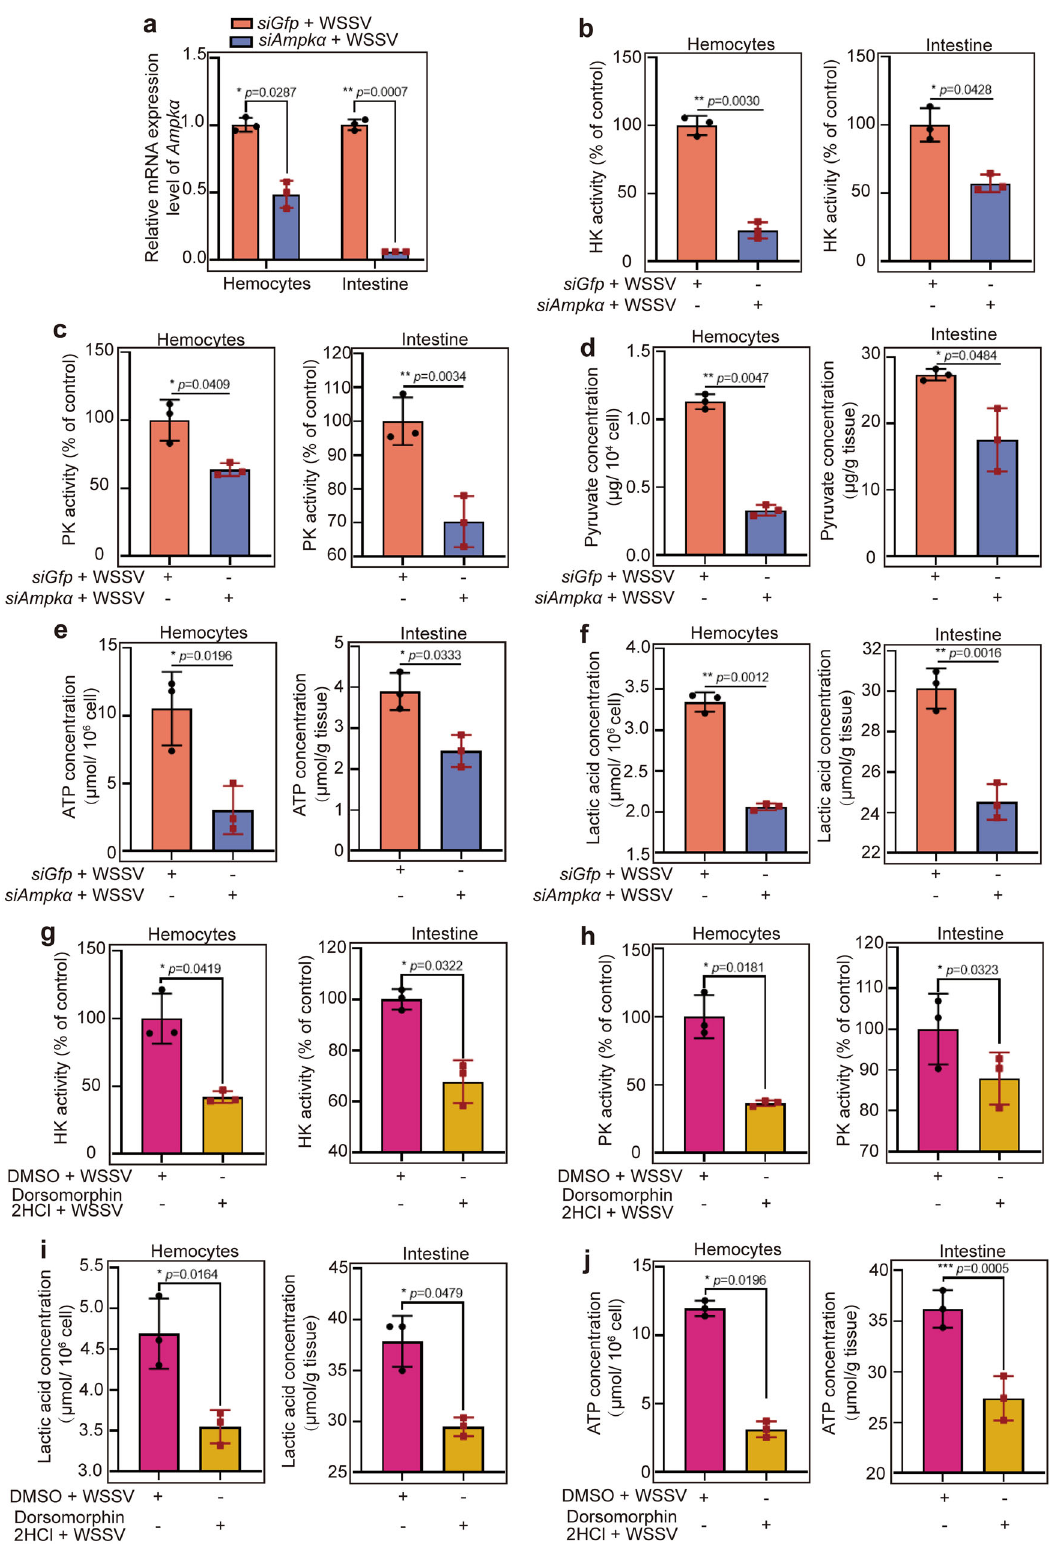
Fig. 8 Knockdown or activity inhibition of AMPK impaired the glycolytic pathway in shrimp induced by WSSV infection. a The ef fi ciency of Ampk α interference in hemocytes and intestines. b , c The enzyme activity of HK ( b ) and PK ( c ) in hemocytes and intestine of Ampk- knockdown shrimp challenged by WSSV. d - f The contents of pyruvate ( d ), ATP ( e ), and lactic acid ( f ) in hemocytes and intestine of Ampk -knockdown shrimp challenged by WSSV. g , h The enzyme activity of HK ( g ) and PK ( h ) in hemocytes and intestine of Dorsomorphin 2HCl-injection shrimp following WSSV infection; and DMSO was used as a control. i , j The contents of lactic acid ( i ), and ATP ( j ) in hemocytes and intestine of Dorsomorphin 2HCl-injection shrimp following WSSV infection; DMSO was used as a control. All results are shown as means± SD for experiments performed at least three times; the data were analyzed statistically using Student ’ s t test. * P < 0.05; ** P < 0.01; *** P < 0.001. COMMUNICATIONS BIOLOGY| (2023) 6:361